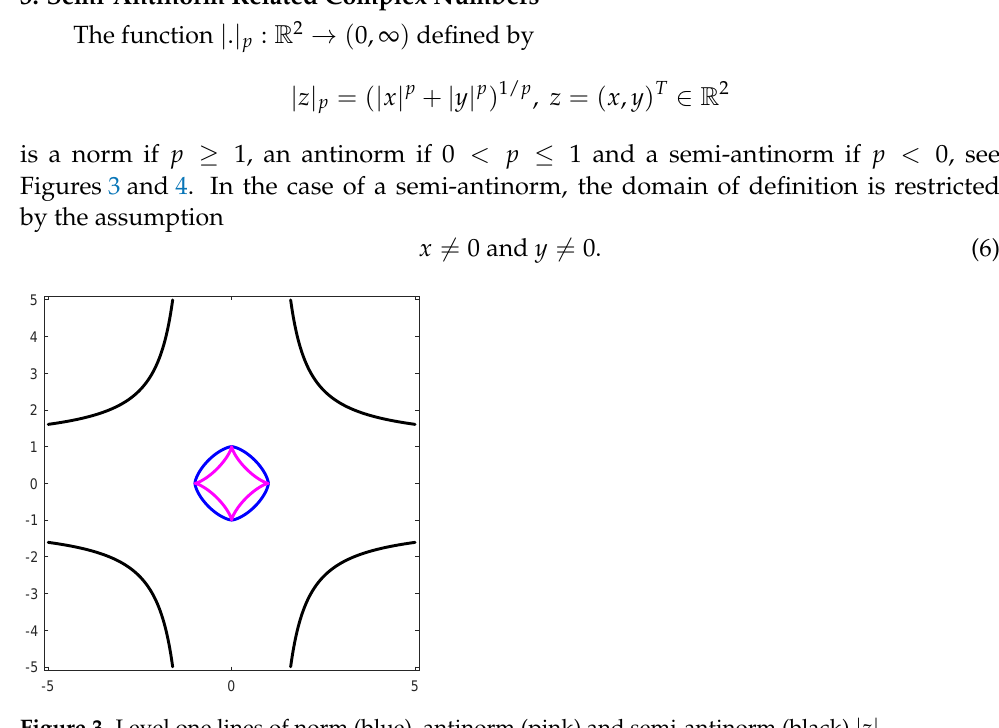
Figure 3. Level one lines of norm (blue), antinorm (pink) and semi-antinorm (black) | z | p .